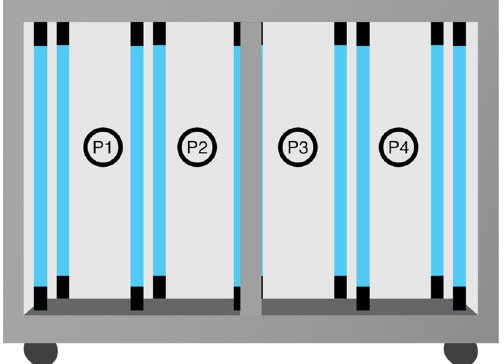
Figure 2. Positional indexing for hanging T-shirts within the UV-C disinfection cabinet.